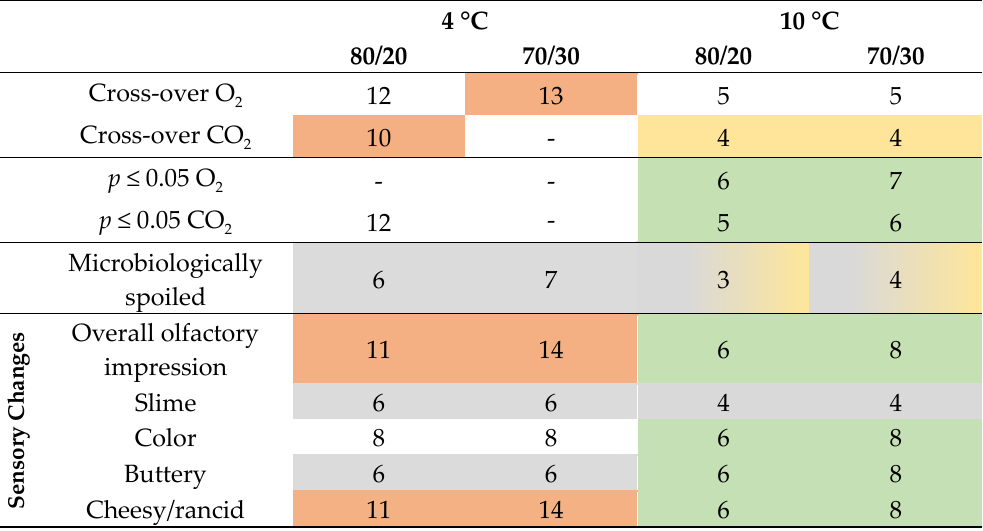
Table 5. Observed correlations between the tested parameters. p ≤ 0.05 represents the first day where the difference between empty and filled trays was significant with p ≤ 0.05, after the cross-over was reached. “Microbiologically spoiled” indicates a TVC of 10 7 CFUg − 1 and “sensory changes” shows the panel classification of the sensory panel with: >50 scores for the overall olfactory impression (“olfactory spoiled”) and an increase of >20 scores in the descriptors slime , color , buttery and cheesy . A description of the color marking of the correlations can be found in the previous text.